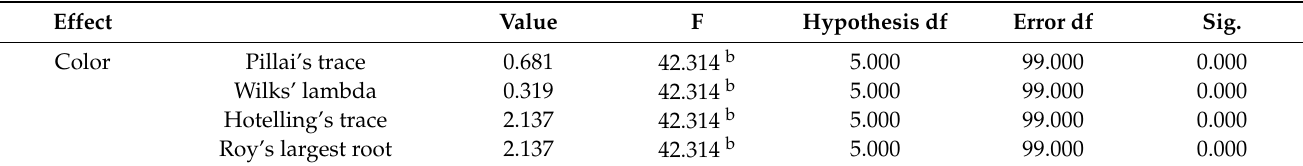
Table 6. Multivariate test a .